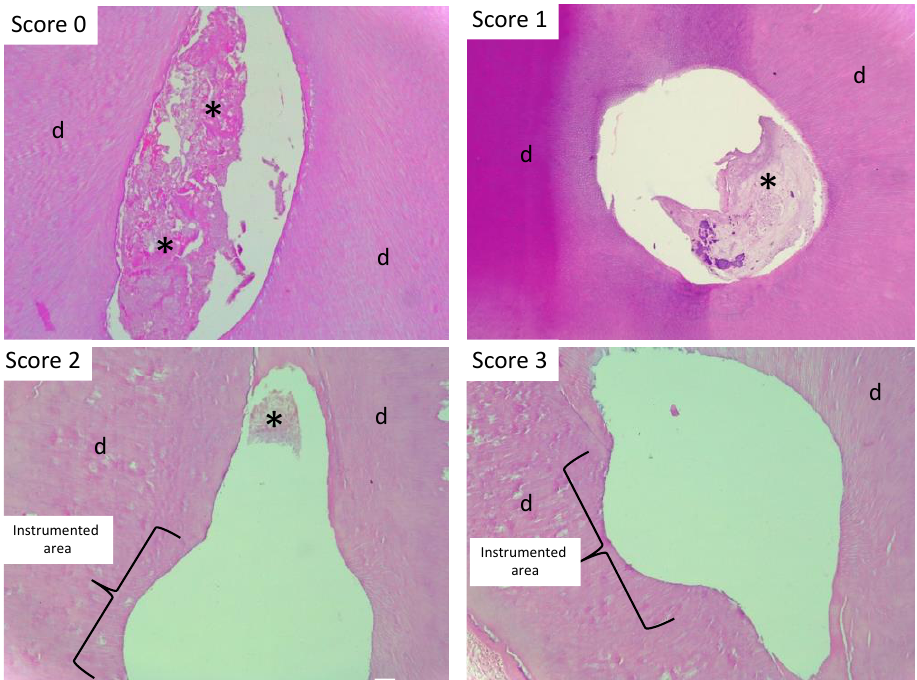
Figure 1. Representative images of the score scale used for the evaluation of root canal cleanness (based on Langeland et al.). Score 0: Root canal with organic remnant, predentin or debris in every histological sample. Score 1: Root canal with organic remnant in most part of the lumen. Score 2: Relatively wide root canal with organic remnant in the margins. Score 3: Absolutely clean root canal. H&E staining. Original magnification: 10×. * = organic remnant. d = dentin.